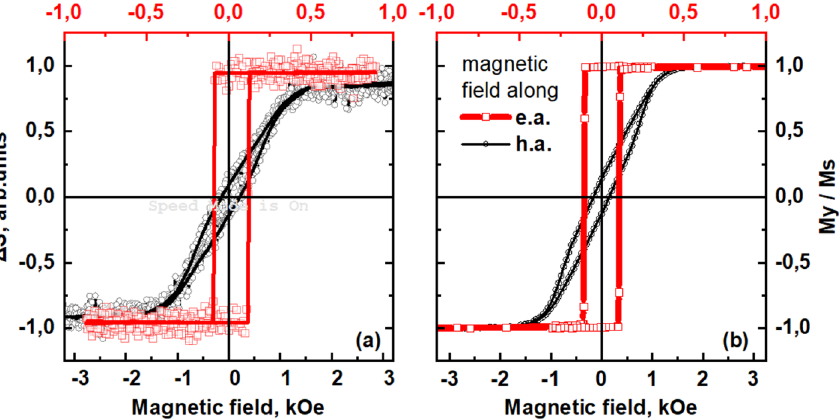
Figure 2. Comparison of the hysteresis loops of magnetization and change in THz signal depending on the applied magnetic field. ( a ) Hysteresis loops of the THz signal (cid:31) S , measured stroboscopically at t = 0 ps (which corresponds to the maximum signal in the time domain profile) with magnetic field applied in the “easy axis” (e.a.) and “hard axis” (h.a.) geometries; ( b ) the corresponding magnetization hysteresis loops for M y ( H ) . Note the difference for top and bottom